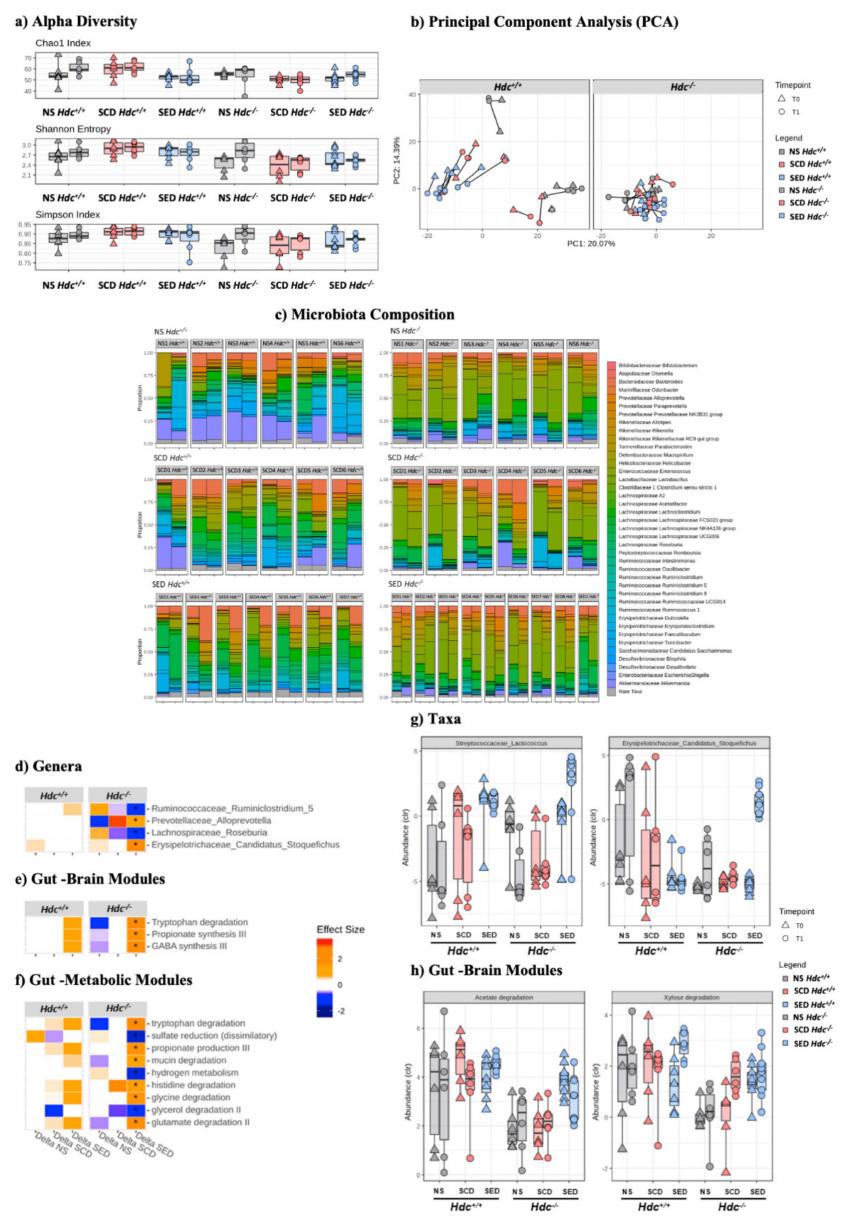
Figure 4. Effect of stress and enriched diet on microbiome. ( a ) Alpha diversity. Non-parametric data are represented as median with inter-quartile ranges (IQR) and min/max values as error bars. Mann–Whitney-U post hoc Bonferroni–Holm. ( b ) PCA showing the microbiome compositions of Hdc +/+ (left panel) and Hdc − / − (right panel) mice, before and after the 10-day chronic stress period. Lines link the same animal over time, showing the trajectory and distance travelled in time. ( c ) Bar plot representation of microbiota composition and response to treatment of Hdc +/+ and Hdc − / − mice of the different experimental groups. ( d – h ) Chronic social stress and the enriched diet shape the gut microbiome profile of Hdc +/+ and Hdc − / − mice. Heatmap for Genera ( d ) Gut Brain Modules and ( e ) Gut Metabolic Modules ( f ) differentially altered by treatment. Colours depict effect size, with blue (negative) indicating higher abundances pre-treatment and red (positive) indicating higher abundances post-treatment. * q < 0.1. Relative abundance of ( g ) taxa and ( h ) Gut Brain Modules that displayed an interaction effect in Hdc − / − SCD mice and treatment. Benjamini–Hochberg adjusted q < 0.1 for all cases. Data were collected from 5 mice per experimental